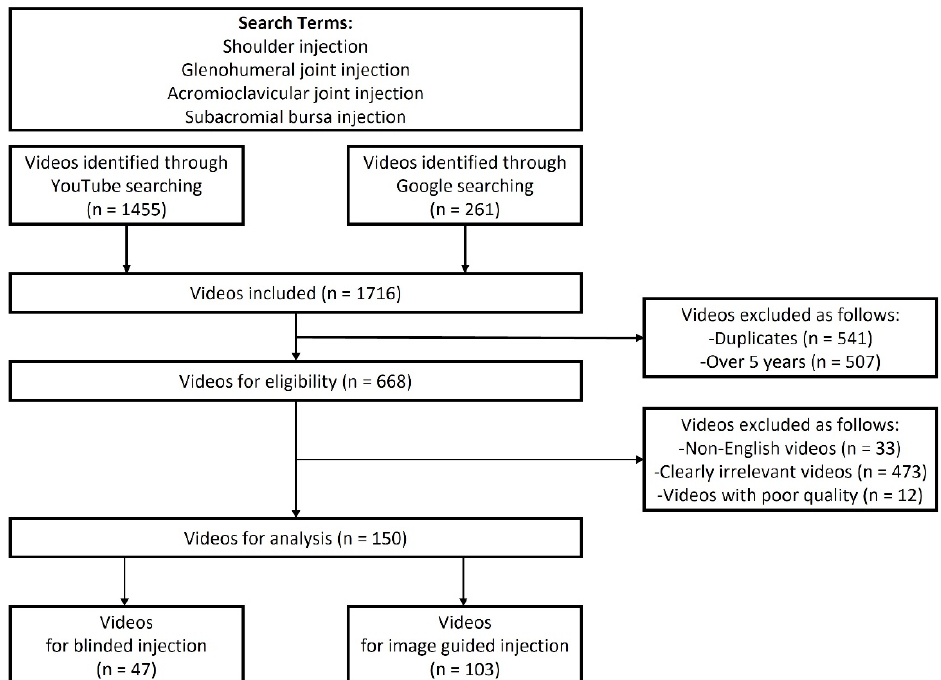
Figure 1. Flowchart for searching videos of shoulder injection treatments on YouTube and Google.